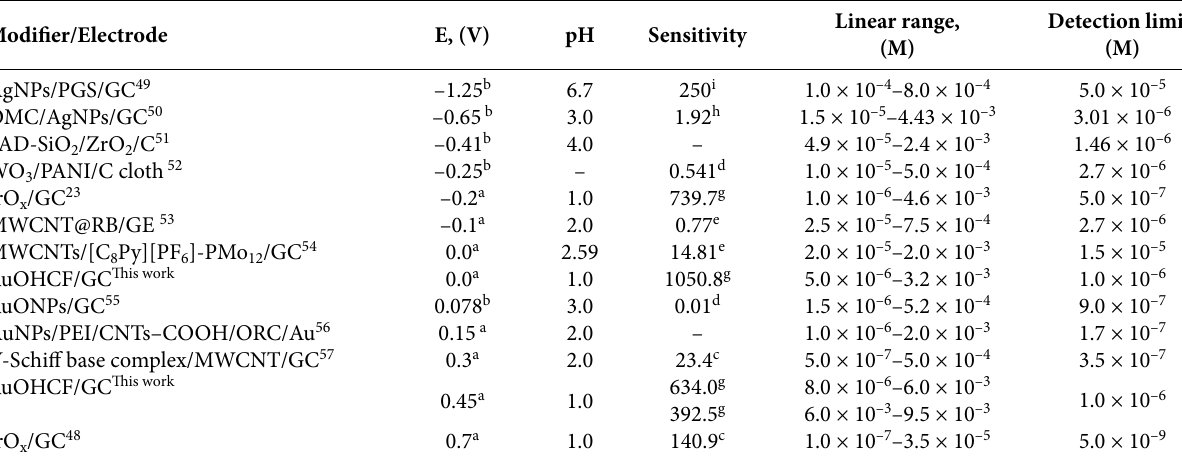
Table 3. Analytical parameters reported for different modified electrodes towards iodate detection.